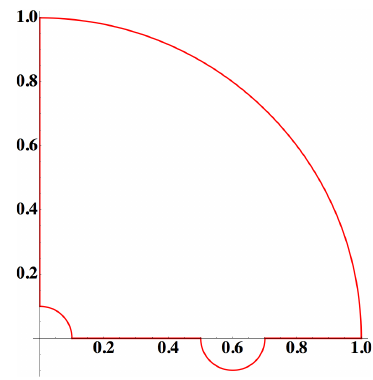
Figure A1. Integration path in the case of an edge